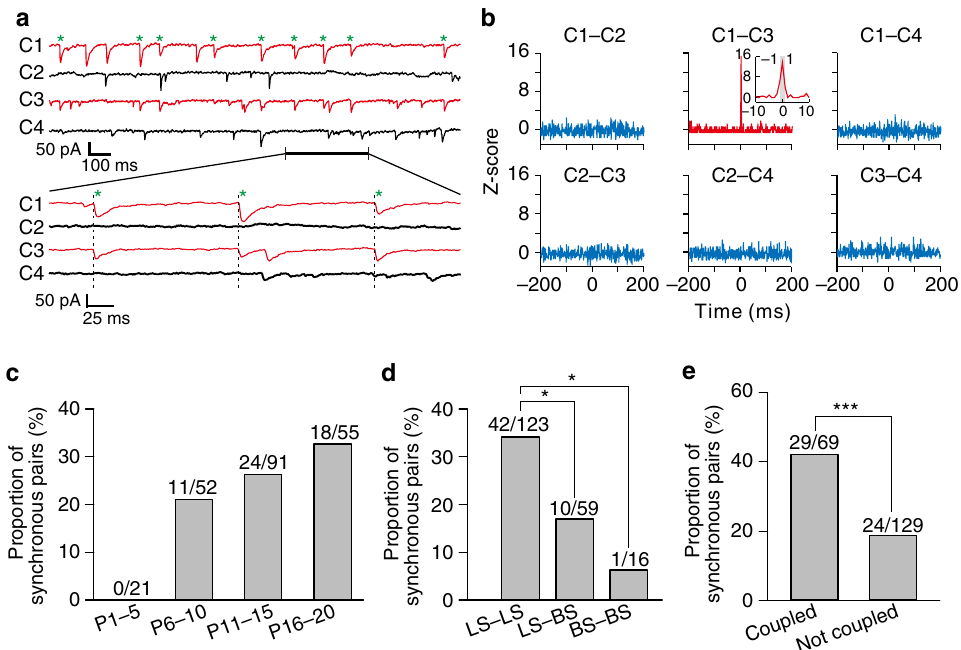
Figure 5 | Synchronous synaptic activity between layer 1 interneurons. ( a ) Sample traces of spontaneous activity of four layer 1 interneurons. High-temporal- resolution displays of a segment of recordings (thick black line) are shown at the bottom. Green asterisks and dotted lines indicate synchronized events between two neurons (cell 1 and 3, red traces). ( b ) Normalized cross-correlogram ( Z -score) for neuron pairs in a . Bin size is 1ms. Note that the frequency of events is significantly increased at B 0ms (inset) for the interneuron pair (1 versus 3, red), but not for any other neuron pairs. The grey region in the inset corresponds to (cid:2) 1ms r D t r 1ms. Similar symbols and displays are used in subsequent figures. ( c ) Proportion of layer 1 interneuron pairs exhibiting synchronized spontaneous activity at different developmental stages. Note that synchronous synaptic activity appeared to be correlated with the developmental process. ( d ) Proportion of layer 1 interneuron pairs of different subtypes from P6 to P20 exhibiting synchronized spontaneous activity. ( e ) Proportion of electrically coupled or not coupled interneuron pairs from P6 to P20 exhibiting synchronized spontaneous activity. n ¼ 47 mice. * P o 0.05, *** P o 0.001, w 2 -test and Fisher’s exact